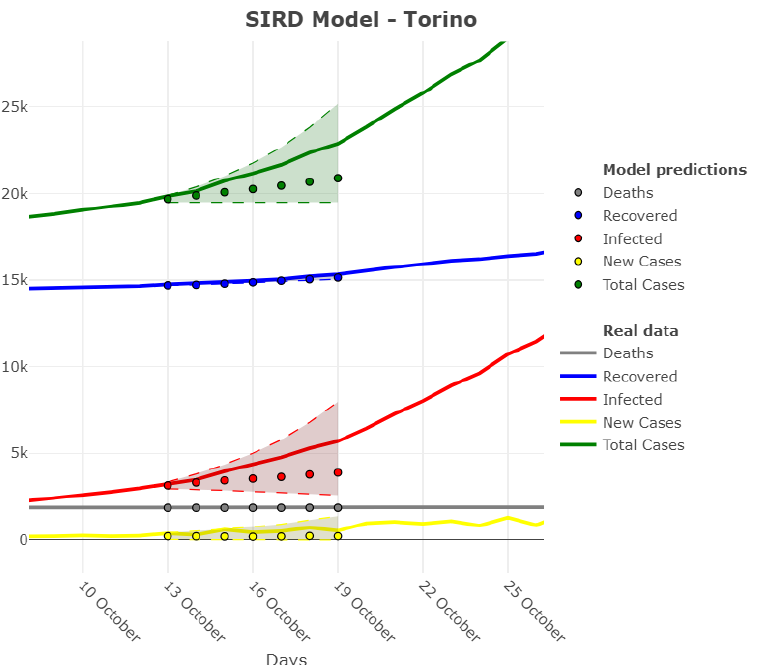
Figure 5. Variables’ prediction intervals based on β interval—Torino province starting from 12 October 2020. The shaded region represents the 90% confidence bands, while the dots repre- sent the point predictions. Real values are always within the confidence